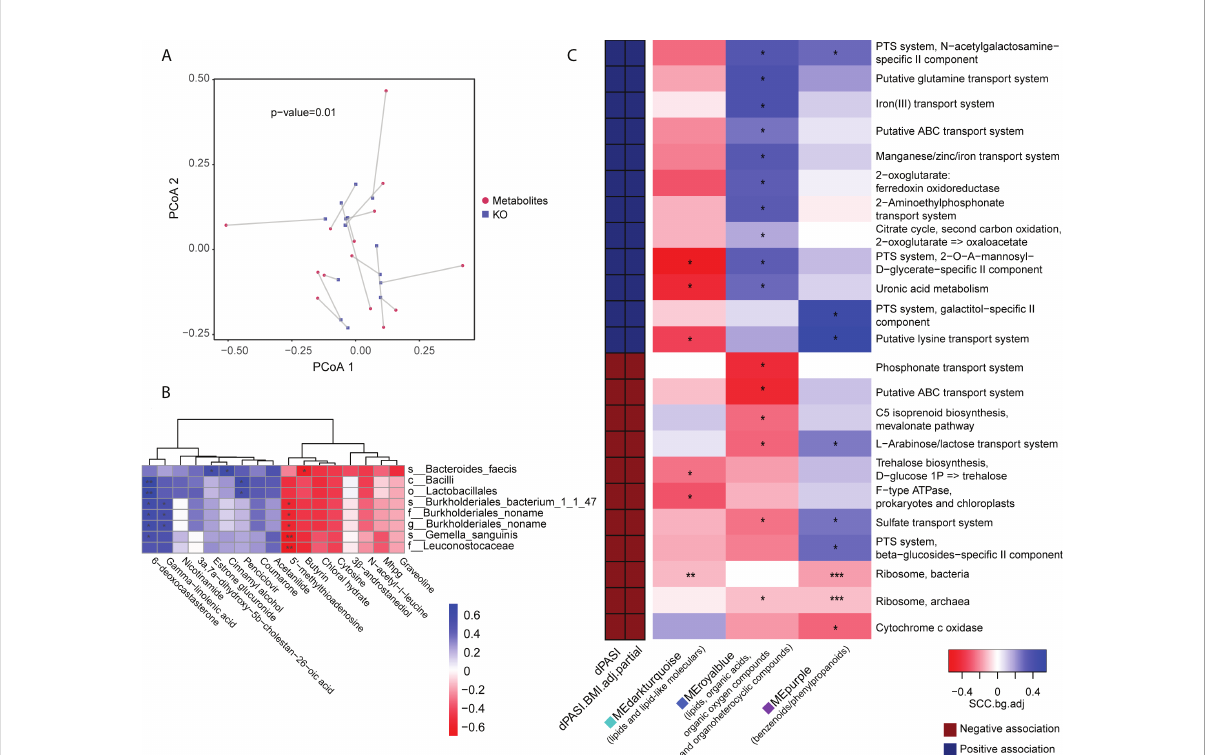
FIGURE 6 Association of metabolomic and metagenomic data in baseline samples. (A) Procrustes analysis for metabolome and microbial KO gene. (B) Association of differential bacteria and differential metabolites identi fi ed in baseline comparison. (C) Association map of the clinical phenotypes, the KEGG function modules of the gut microbiome, and the metabolome modules. The left panel shows signi fi cant associations (Wilcoxon rank-sum test p < 0.05) between KEGG modules and the dPASI. Red: negative association; blue: positive association. The right panel shows associations between the same KEGG modules and serum metabolite modules (Wilcoxon rank-sum test p < 0.05). Coloring represents the median Spearman correlation coef fi cient between metabolite modules and the indicated KEGG modules, corrected for background distribution [SCCbg.adj; more details in Pedersen et al. (23)]. FDRs are denoted: *FDR < 0.1; **FDR < 0.05; ***FDR <